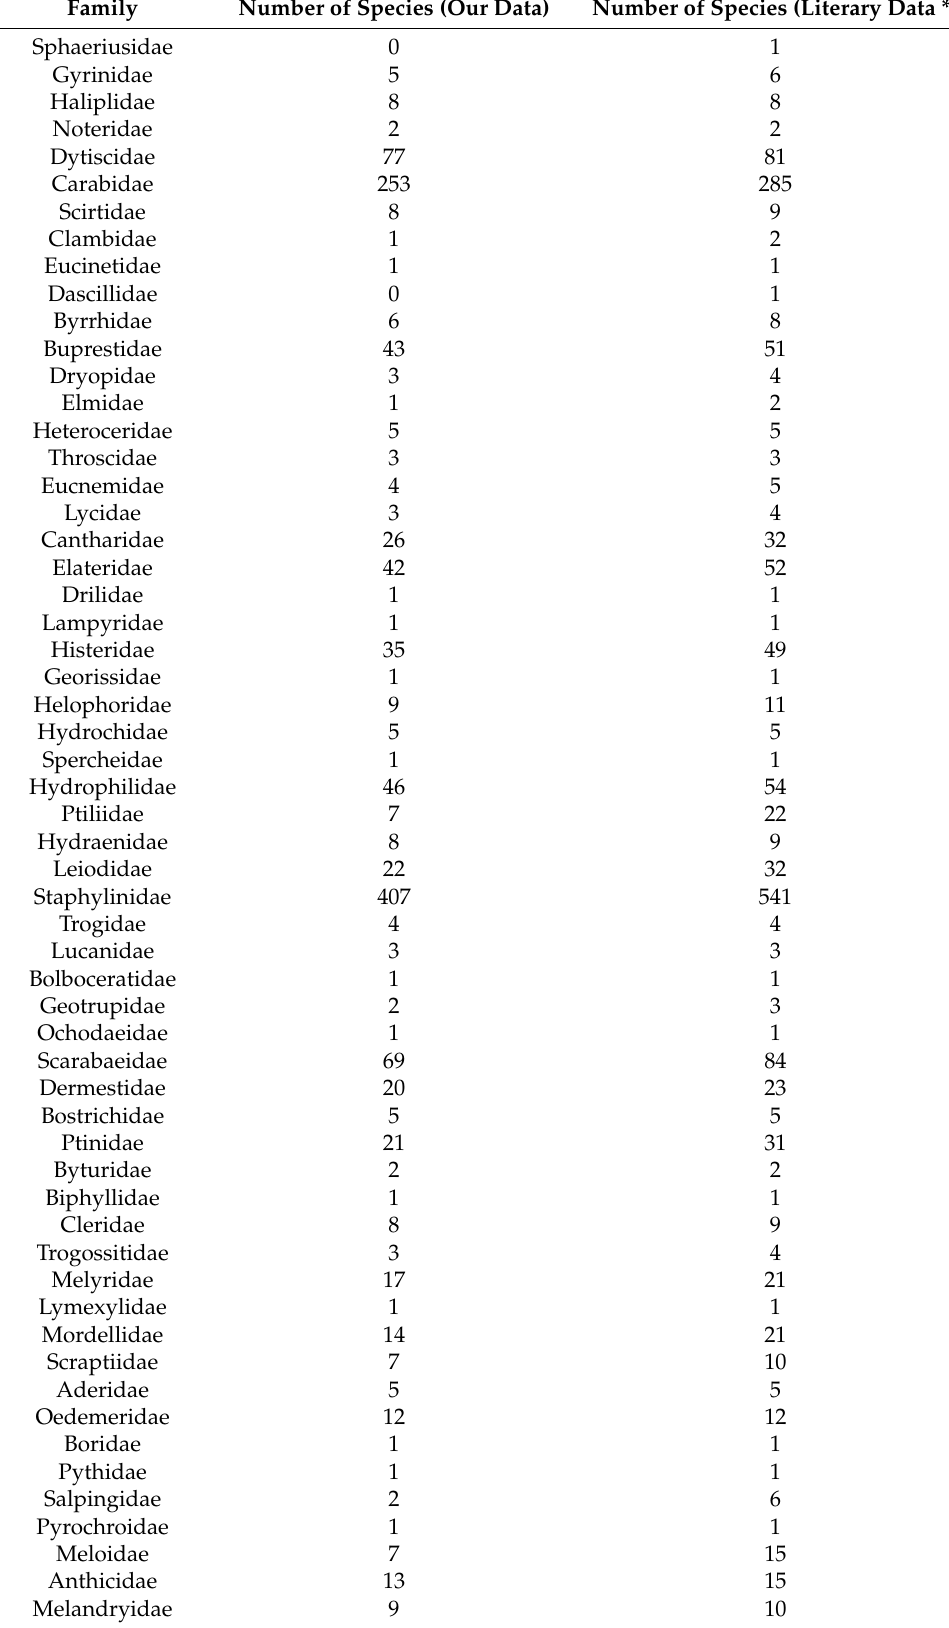
Table 2. Species diversity of beetles of the Lipetsk